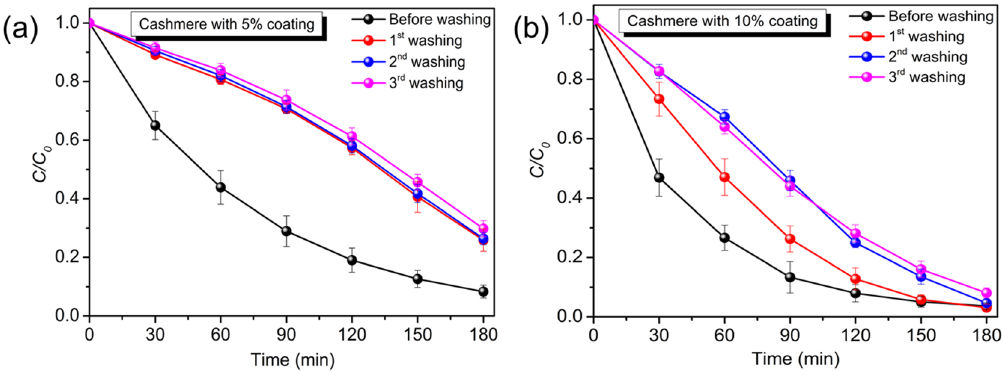
Figure 5. Photocatalytic activity of ( a ) 5% and ( b ) 10% TiO 2 -coated cashmere fabrics before and after washing (Error bar: three times).